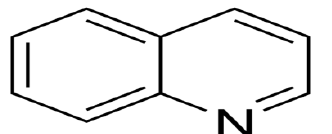
Figure 1: Basic structure of quinoline